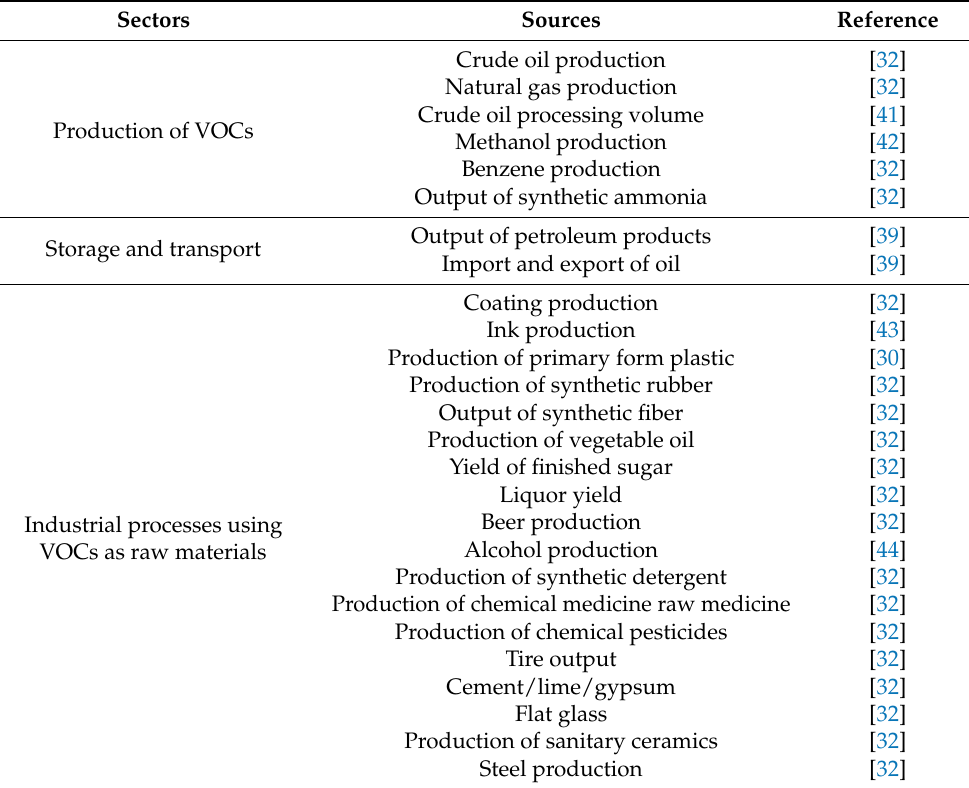
Table 1. Source classification and activity level of the major industrial VOC emission